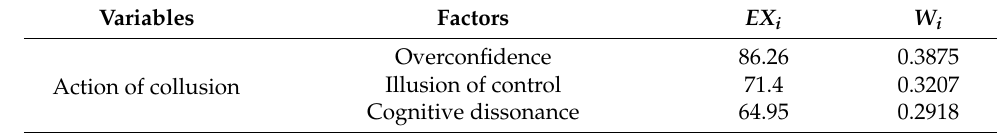
Table 2. Main variables and factors of the model.